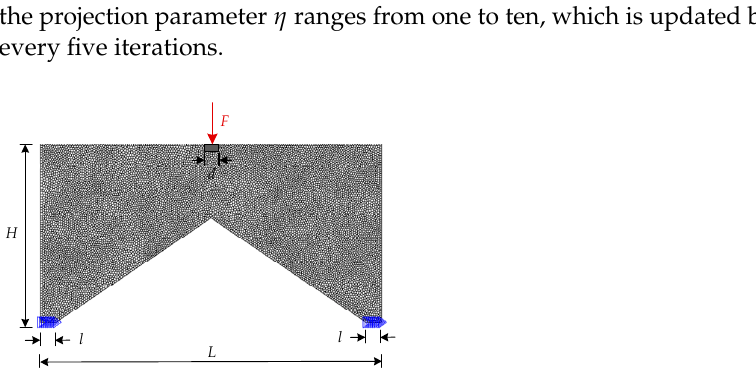
14 of 18 Figure 11. Optimal topology and damage distribution for an antenna bracket under multiple loads.